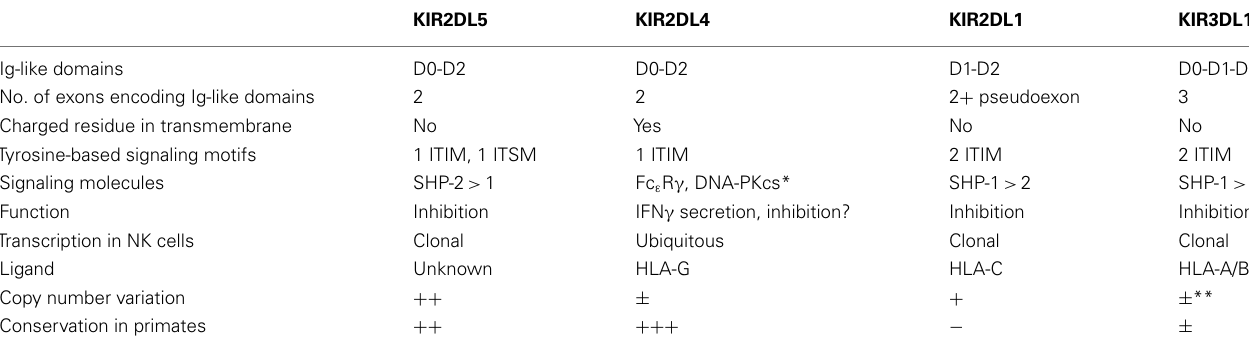
Table 1 | Structural, genetic, and functional features of KIR2DL5 in comparison with other human